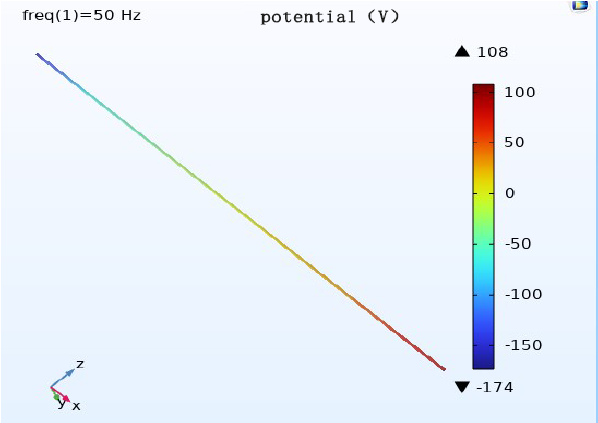
Figure 9. Distribution of cathodic protection potential at voltage level 750 kV.